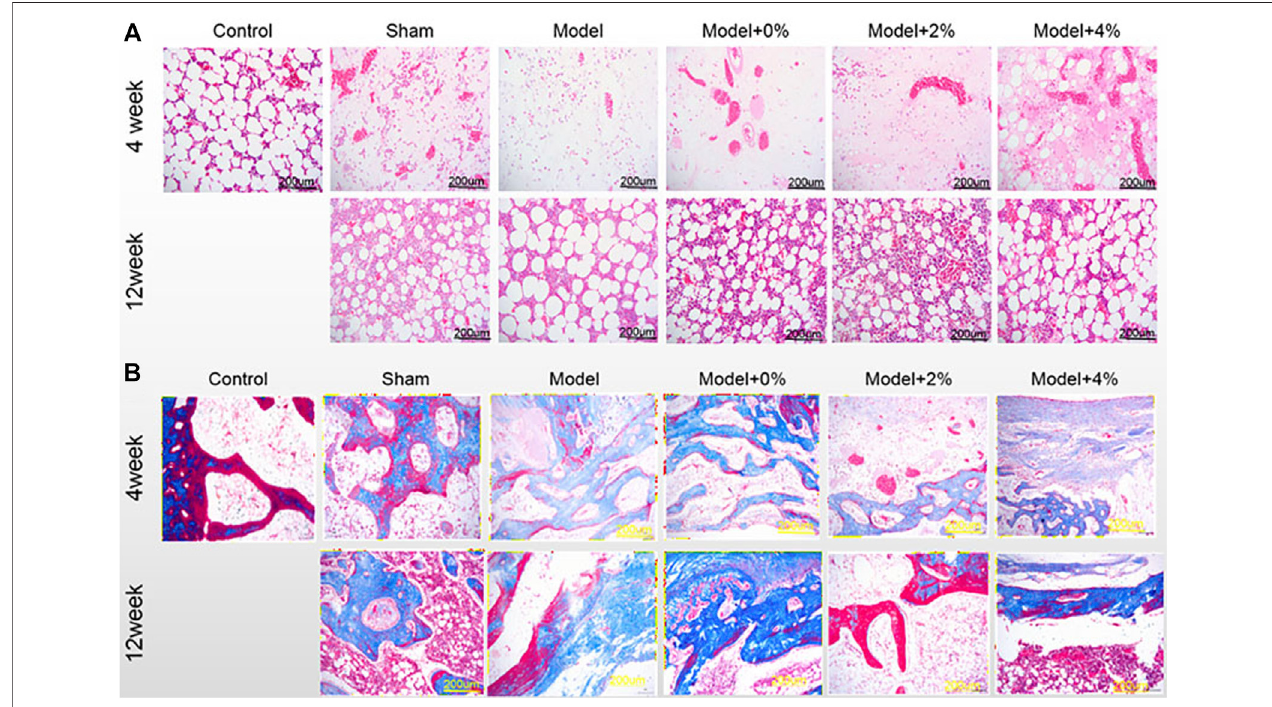
FIGURE 4 | (A) H&E staining and (B) Masson-trichrome staining of the bone tissues at 4 and 12 weeks post-surgery. (200×).